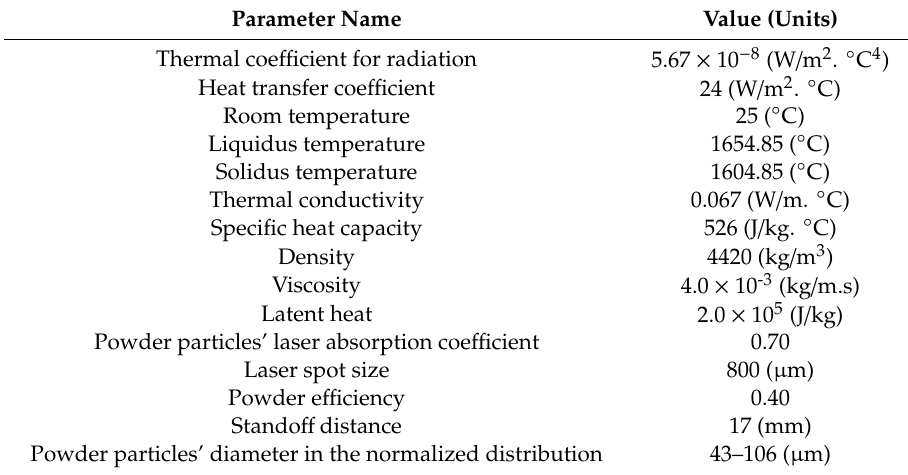
Table 1. Thermo-physical properties of Ti6Al4V alloy powder deposition on the Ti6Al4V alloy substrate